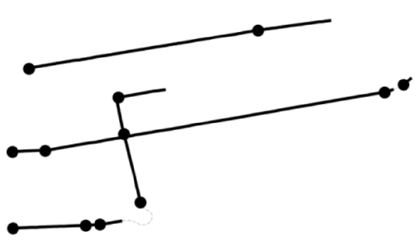
Figure 6. Straight-line segment extraction using the maximum reconstruction error method.